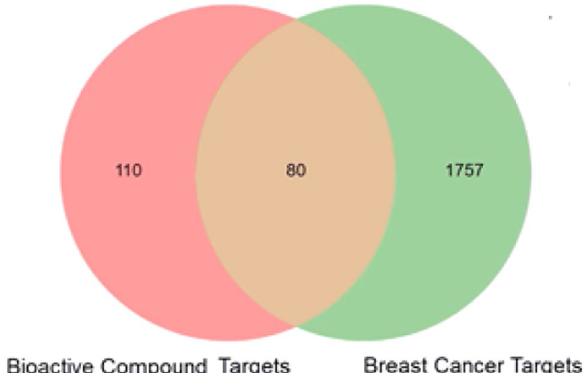
Fig. 1 Venn diagram showing the S. nigrum bioactive compound targets and breast cancer targets